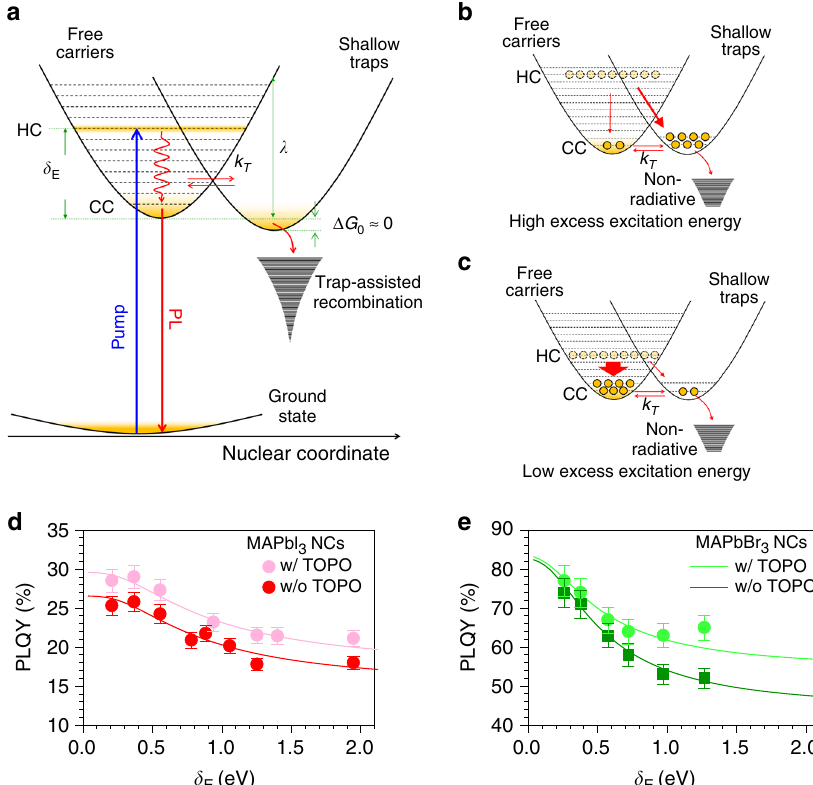
Fig. 3 Phenomenological model of hot carrier-induced trapping. a Model schematic describing the interaction between carriers and shallow traps in PNCs. Free and trapped carriers are involved in a thermal equilibrium, whose barrier is dictated by the combination of reorganization energy, λ , and trapping free energy – Δ G 0 . b The high-excess energy ( δ E ) for the carriers increases the trapping rate and hence results in a higher number of trapped carriers, i.e., lower PLQY. c Vice versa, lower δ E results in lower trapping rate and thus results in a lower number of trapped carriers, i.e., higher PLQY. HC and CC indicate the hot carriers and cold carriers, respectively. Model fi tting of the photo-action spectra, for ( d ) MAPbI 3 NCs ( e ) and MAPbBr 3 NCs. The light-colored dots represent TOPO ligand-exchanged PNCs, while dark dots represent pristine PNCs. Error bars represent the standard deviation, estimated through repeated measurements. The corresponding colored lines represent the model fi